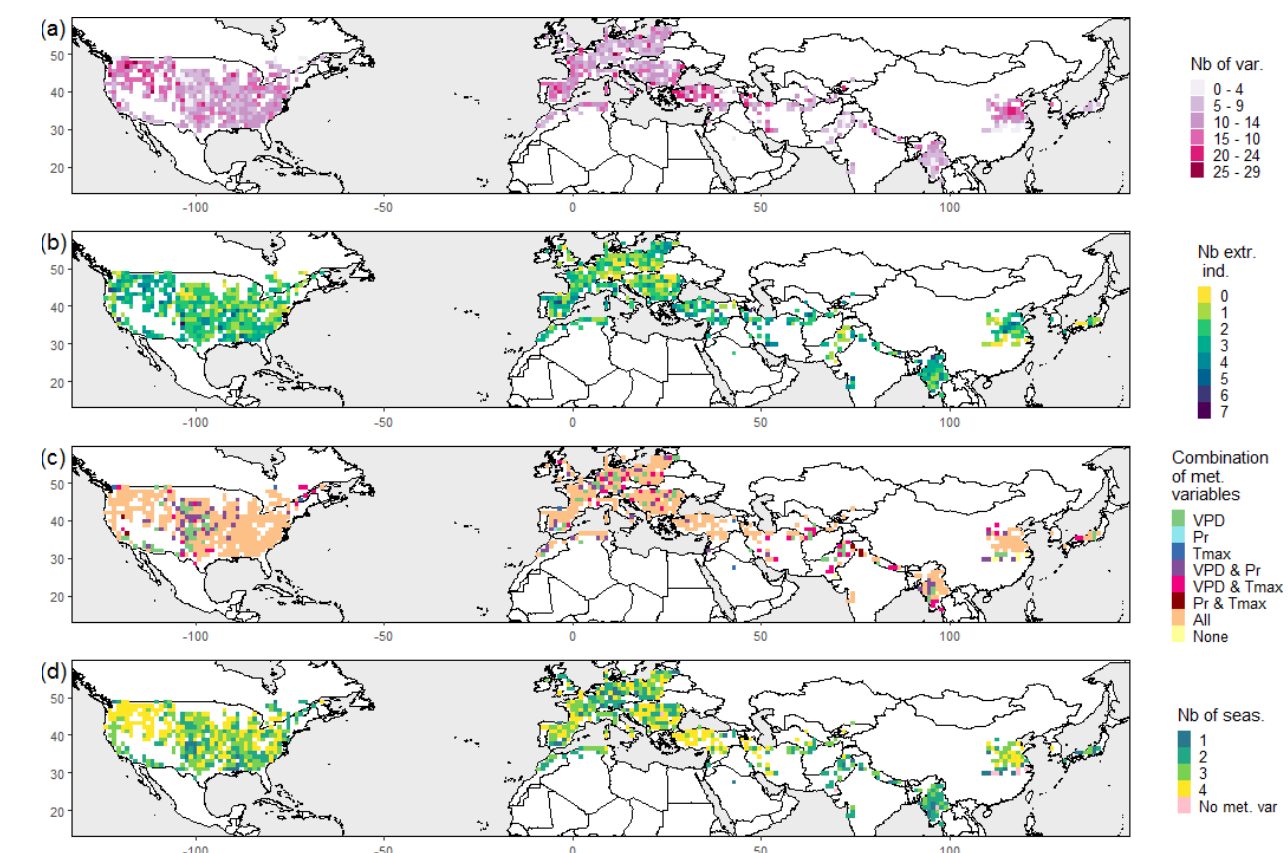
Figure 7. Maps illustrating the selected predictors by the LASSO logistical regression. (a) Total number of selected variables. (b) Number of selected climate extreme indicators. (c) Combination of selected meteorological variables. “None” means that only climate extreme indicators were selected; “All” means that at least 1 month from each of the three meteorological variables (VPD, Pr, T max ) is selected. (d) Number of selected seasons (out of the four seasons – DJF, MAM, JJA,